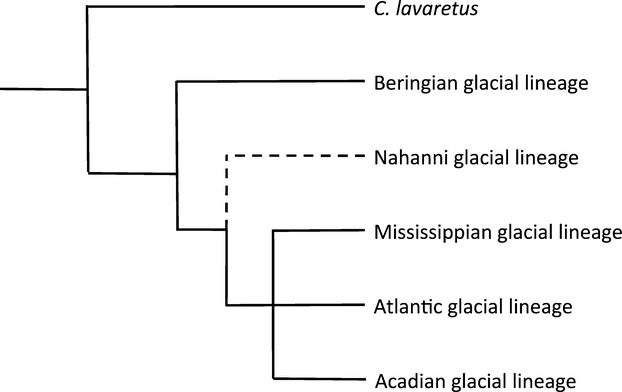
Summary of phylogenetic relationships among lake whitefish glacial lineages. This summary is drawn from the phylogenetic analyses in several studies, many of which use different molecular tools (e.g. allozymes, mitochondrial DNA markers, nuclear markers) to make phylogenetic inferences (Bernatchez and Dodson 1991; Bodaly et al. 1991b; Bodaly et al. 1992; Foote et al. 1992; Bernatchez and Dodson 1994; Bernatchez et al. 1991; Lu et al. 2001). Branch lengths are not to scale. The dashed line represents the data-limited nature of the Nahanni glacial lineage.